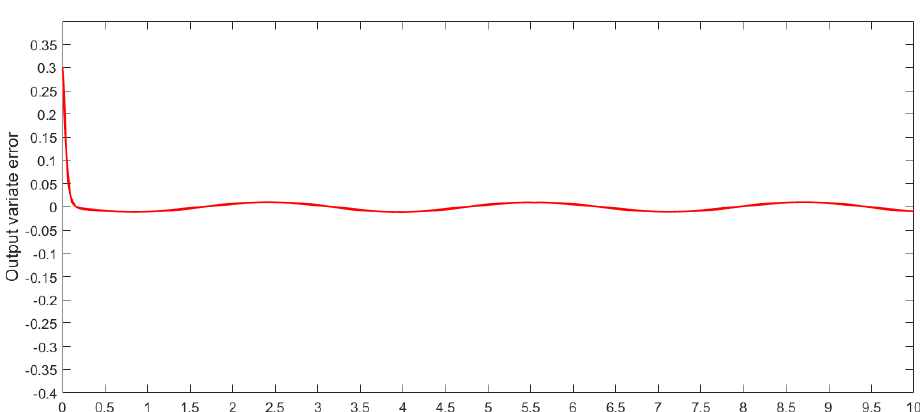
Figure 10. Maglev train displacement tracking curve.